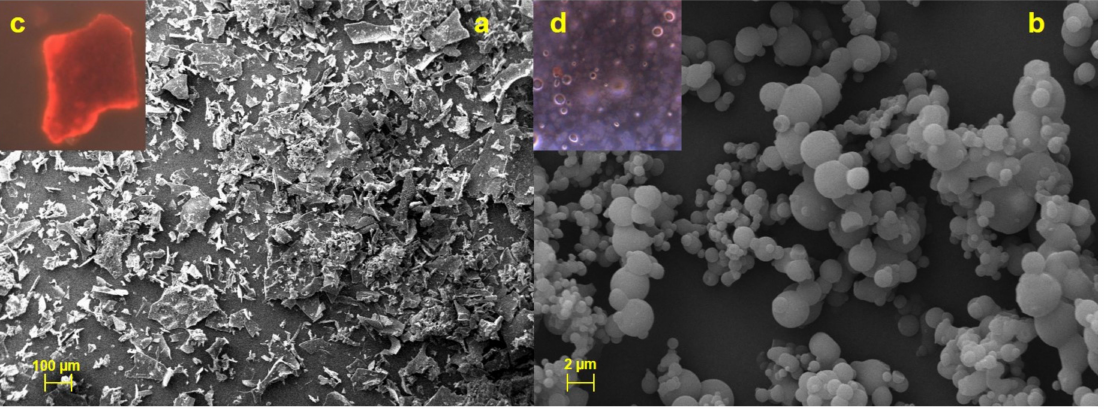
Figure 3. SEM and FM micrographs of HSE ( a and c ) and CM-HSE ( b and d